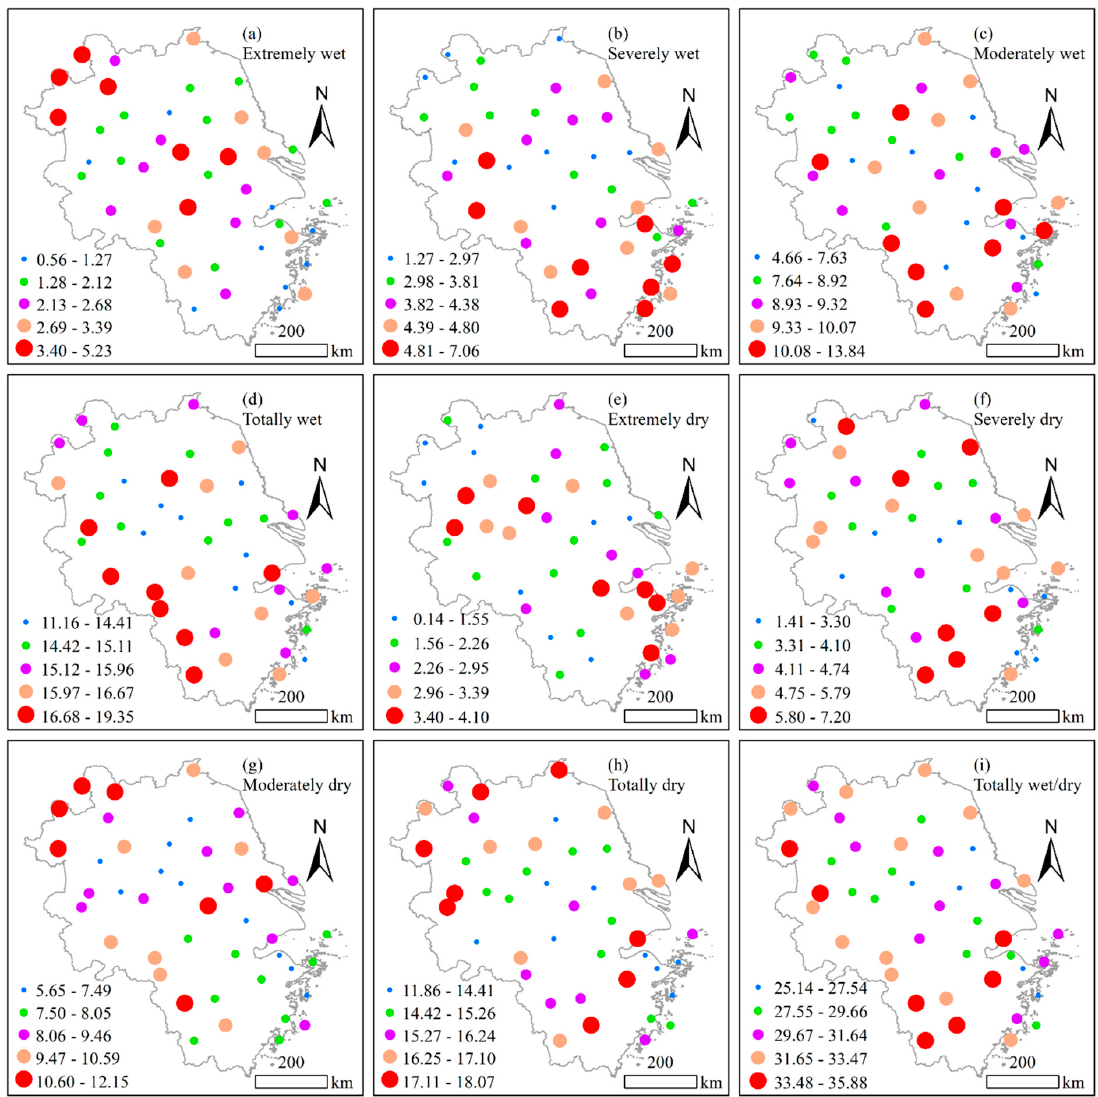
Figure 4. Spatial patterns of the frequencies (%) for different types of wet/dry events.